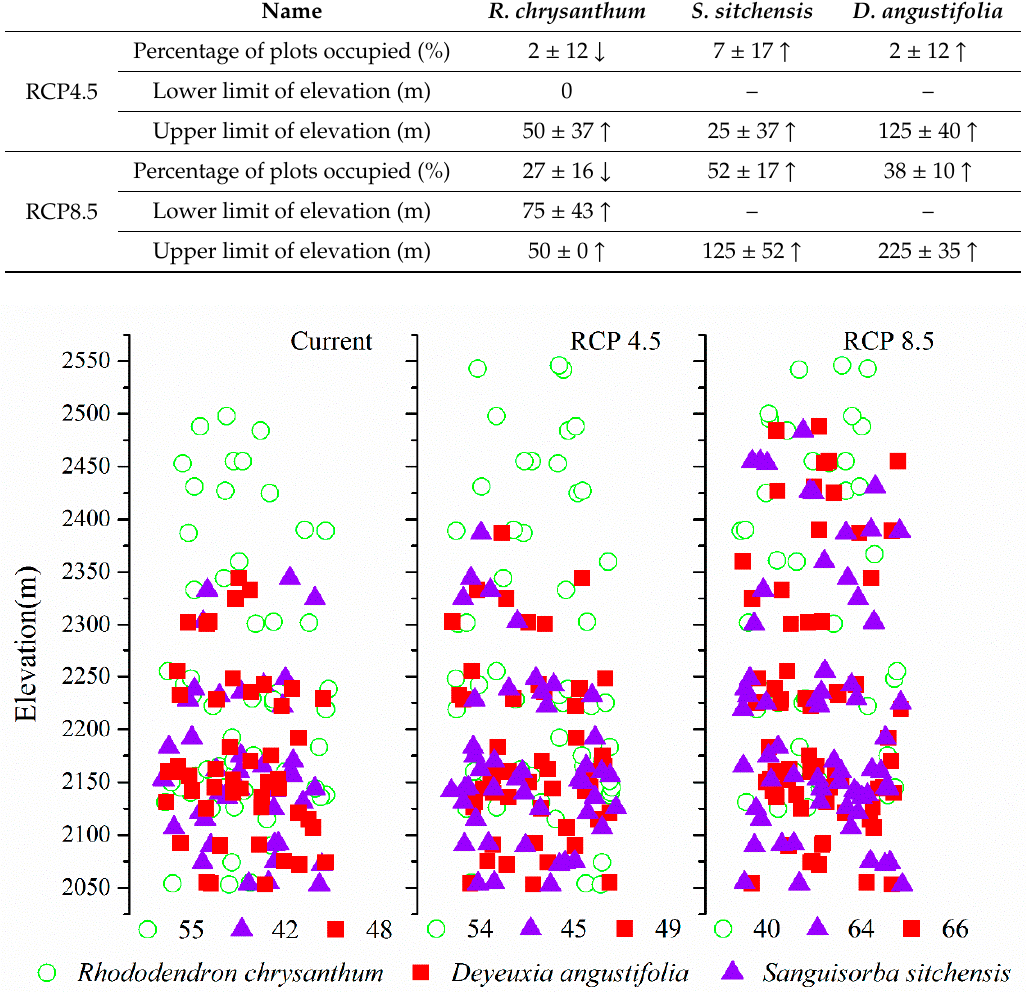
Figure 5. Potential changes of elevation and the number of plots for each dominant tundra plant species by 2045 under the RCP 4.5 and RCP 8.5 scenarios in Changbai Mountains.